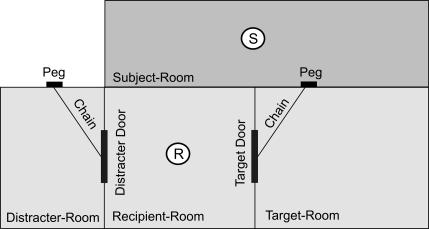
Test Area and Setup in Experiment 3Both the target and the distracter door were held shut by chains. The recipient (R) could not access either chain, but the subject (S) could release the chain of the target door. In the experimental condition, food was placed in the target room, so that the recipient would try to open the target door and the subject could help by releasing the target chain. In the control condition, food was placed in the distracter room, so that the recipient would try to open the distracter door. In this situation, it was irrelevant (with respect to the recipient's attempt to open the distracter door) whether the subject released the target chain. The target measure in both conditions was whether the subject released the target chain.